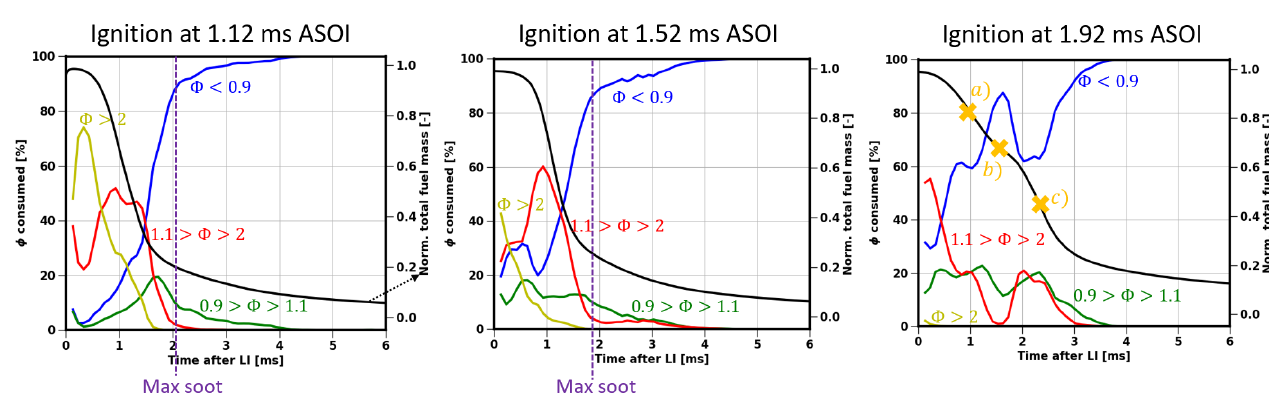
Figure 16. Equivalence ratio ( Φ ) consumed by the high-temperature flame. The Φ distribution is binned into four groups shown in yellow, red, green, and blue ( y -axis on the left). The normalized total fuel mass in the domain (black curve) is plotted using the right y -axis. The time corresponding to maximum peak soot concentration is displayed with vertical dashed purple